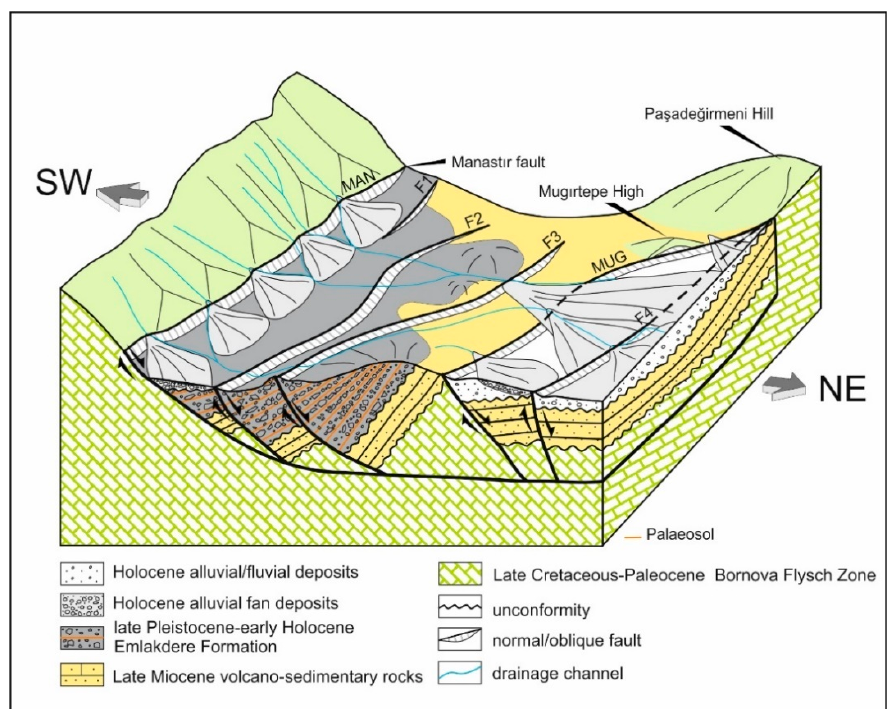
Figure 4. 3D view of western Manisa Fault Zone showing the staircase of fault scarps in the Manastır hangingwall. MAN: Manastır, MUG: Mugırtepe. Note that in the cartoons the exact horizontal and vertical scales, vertical displacement values as well as thickness of sedimentary layers are disregarded. However, MAN fault depth is known to be 5–10 km in about 10 km northeast of Manisa.